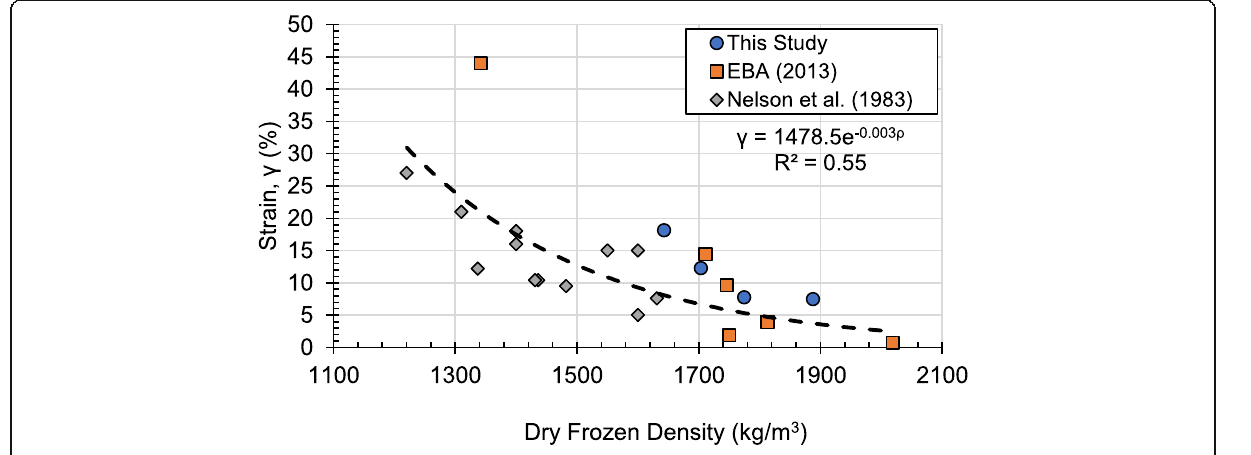
Fig. 8 Percent strain as related to dry frozen density for sand and silty sand